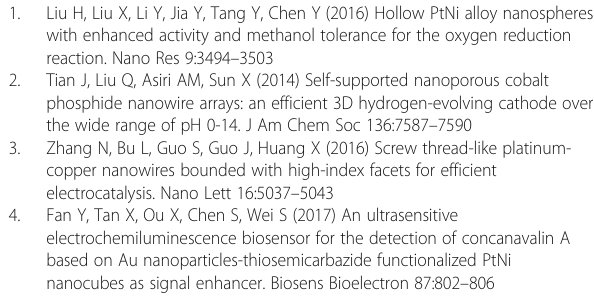
Additional file 1: Figure S1. XRD patterns of PtNi jagged-like nano- wires. Figure S2 (a) Pt 4f and (b) Ni 2p deconvoluted XPS spectras of PtNi jagged-like nanowires. Figure S3 The CVs of 0.48 μ g PtNi/C modified GCE in 0.1M BR buffer solution containing 0.5mM caffeic acid at pH ranging from 1.0 to 7.0 (a) and the plots of the anodic peak potential against pH (b). Figure S4 CVs of the 0.48 μ g PtNi/C modified GCE in 0.1M BR buffer solution (pH= 2.0) containing 0.5mM caffeic acid at scan rates from 20 to 200mVs − 1 (a) and the plots of anodic and cathodic peak currents to the scan rates (b). Figure S5 The CVs of the 0.48 μ g PtNi/C electrode (a) and Pt/C electrode (c) in 0.5mM CA after various numbers of potential cycles (1 – 4000 cycles) at a scan rate of 100 mVs − 1 . The oxidation peak currents of 0.48 μ g PtNi/C electrode (b) and Pt/C electrode (d) vs number of cy- cles. Figure S6 (a) TEM images, (b) HAADF-STEM images and (c) STEM- EDS elemental mapping of Pt-Ni jagged-like nanowires after subjecting the sample to potential cycling for 4000 cycles between 0.1 – 1.0V in 0.1M BR buffer solution electrolyte at 100 mVs − 1 . Figure S7 Relative analytical response (I pa /I p ) of PtNi/C electrode in 0.1M BR buffer solution (pH= 2.0) containing 0.5mM caffeic acid in presence of different interfering species: 10mM tannic acid, resveratrol, tartaric acid, gallic acid, citric acid, P- coumaric acid, succinic acid, and malic acid. Table S1 Comparison of the linear range and detection limit between the proposed method and other reported detection methods for caffeic acid. Table S2 Determin- ation of CA in red wine samples (DOCX 2679 kb)